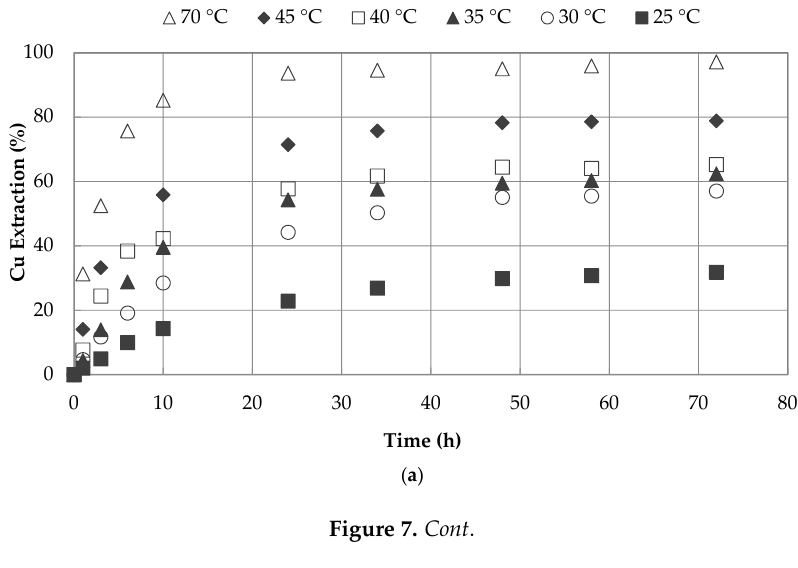
( b ) Figure 7. Effect of temperature on copper extraction using H 2 SO 4 (1 M), NaNO 3 (1 M), 3 days of leaching: ( a ) seawater and ( b ) water. Copper extraction was higher in the seawater-based media than in the water-based media independent of temperature. The increase in temperature from 25 to 70 °C resulted in an increase in the copper extraction rate from ≈ 31% to ≈ 97% when seawater was used. 3.6. Effect of Synthetic Saline Solution Figure 8 compares the kinetic curves of copper extraction in seawater and a synthetic saline solution. The kinetics curves in Figure 8 show that the two extraction rates are similar. The small variations may be related to the presence of SO 42 − ions in the seawater. Other ions in seawater, such as calcium, potassium, magnesium, do not contribute significantly to leaching under the conditions in this work. Figure 8 shows that chloride ions, present in both solvents, helped in the leaching process.